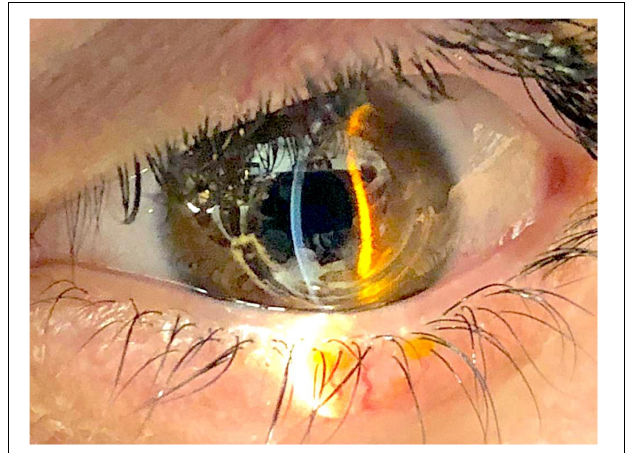
FIGURE 1 | Anterior segment photography showing ring extrusion.